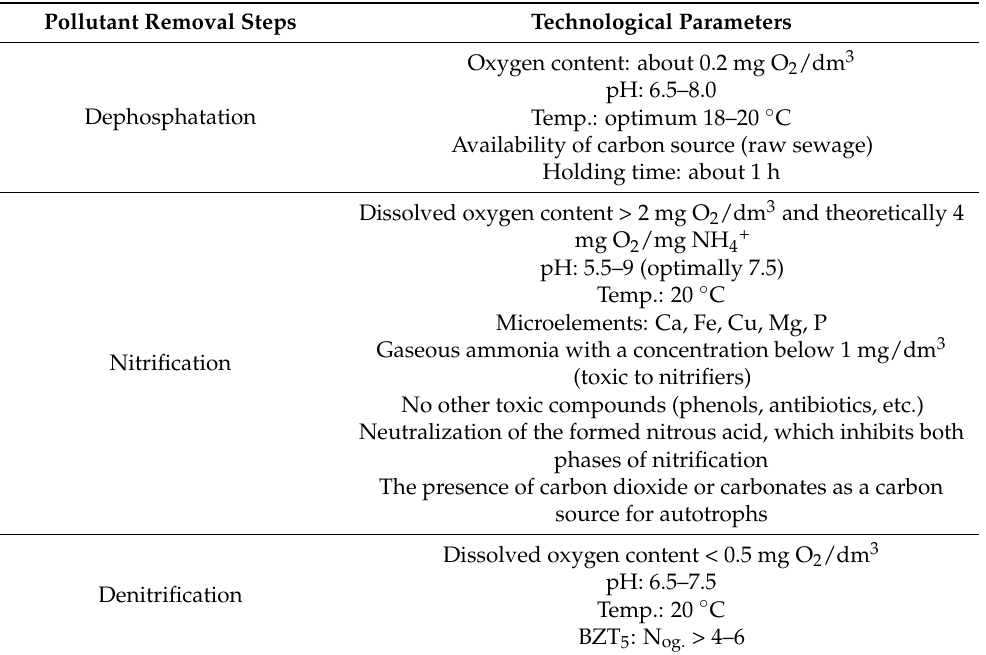
Table 3. Pollutant removal steps in aerobic wastewater treatment systems and their required techno- logical